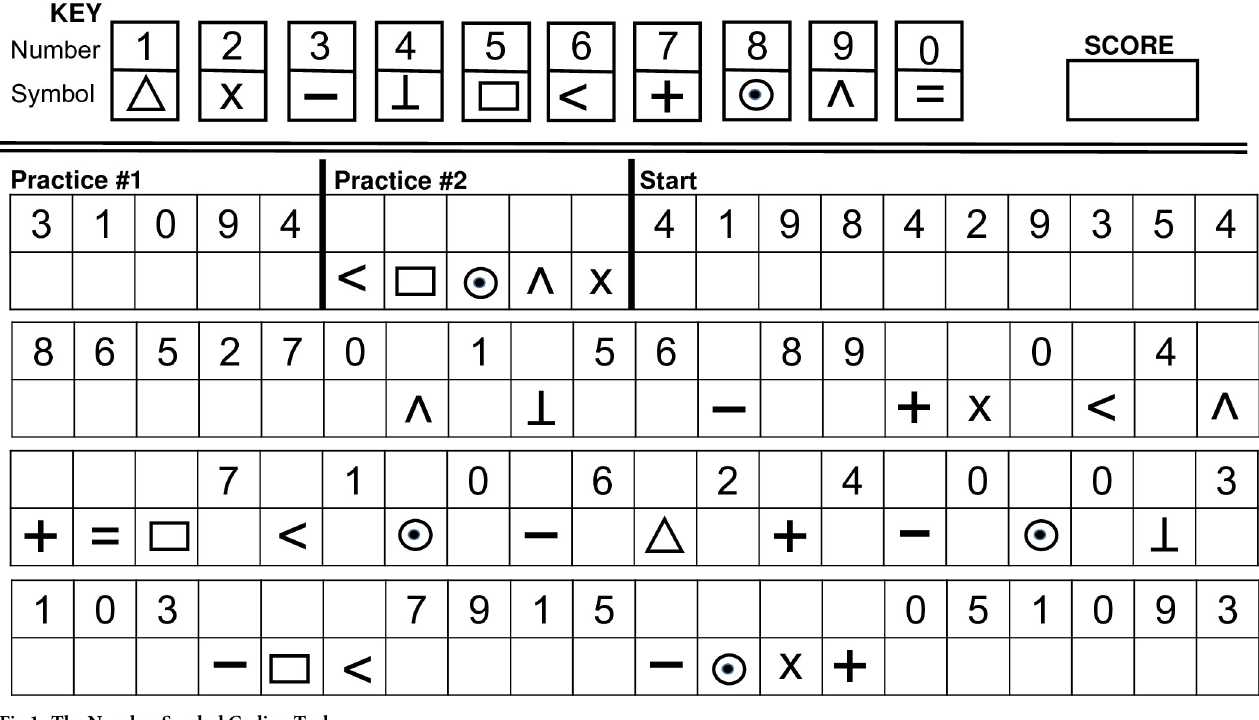
Fig 1. The Number Symbol Coding